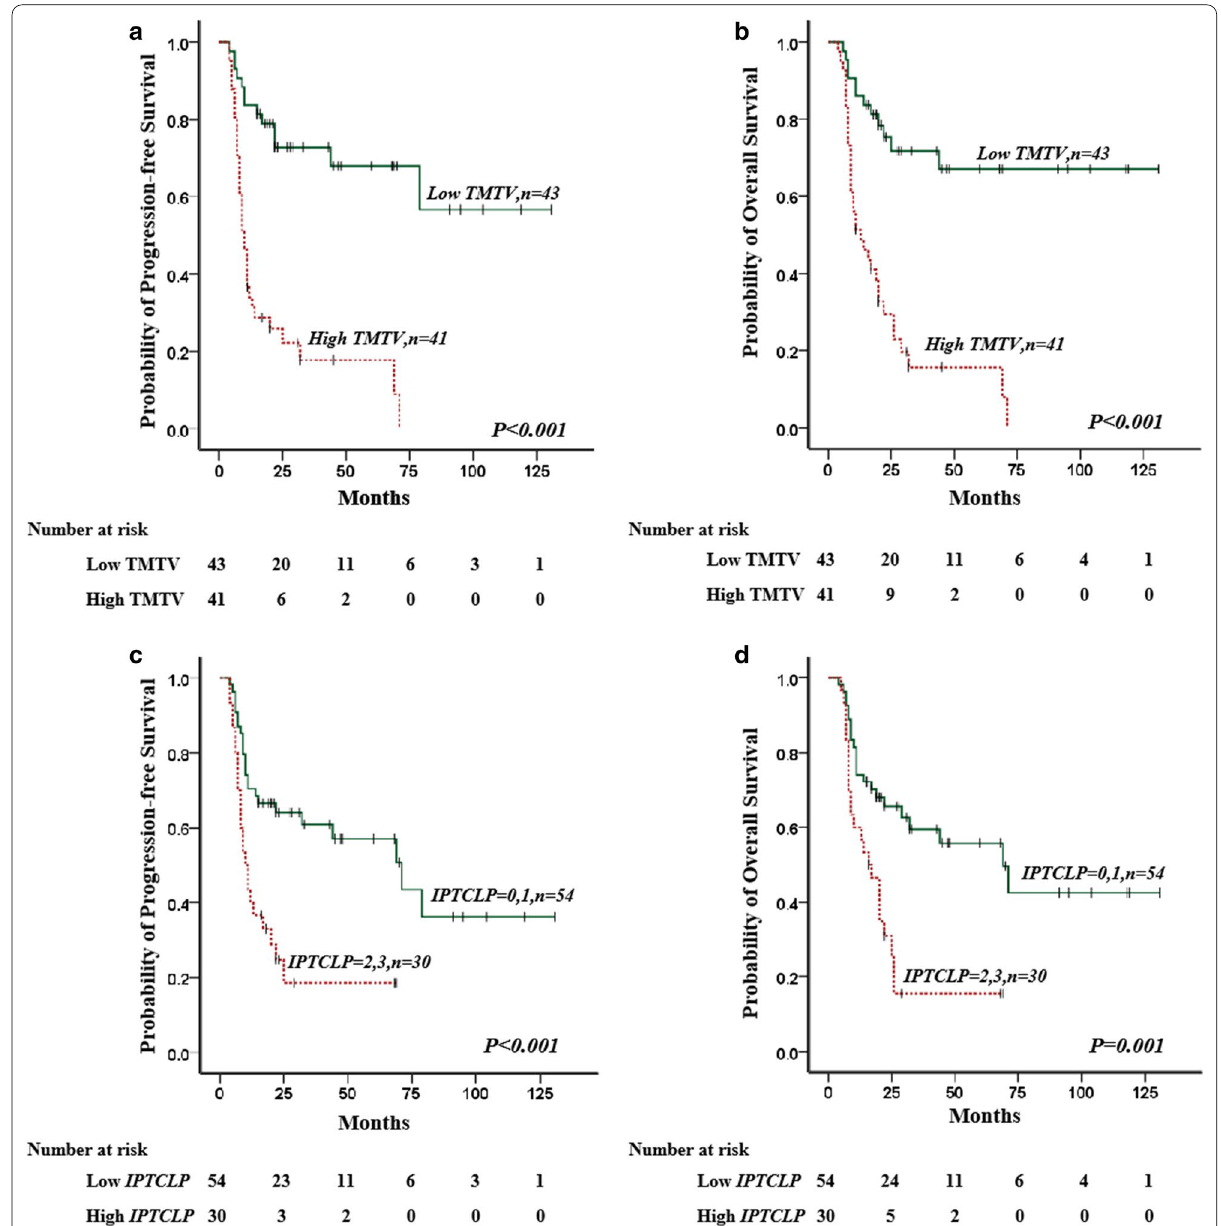
Fig. 1 Overall survival (OS) and progression-free survival (PFS) of patients with peripheral T-cell lymphoma. a , b The PFS and OS of the PTCL patients could be successfully distinguished by TMTV ( P < 0.001 and P < 0.001). c , d The PFS and OS of the PTCL patients could be successfully distinguished by IPTCLP scores ( P < 0.001 and P =